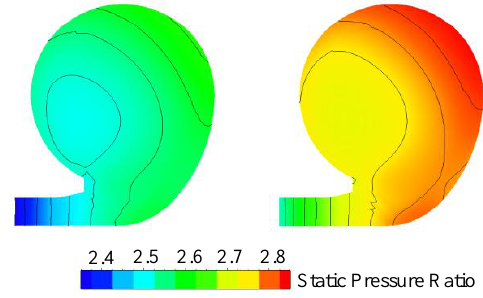
Figure 21. Distribution of static pressure ratio of 0-0 section of the volute ( left : plain, right : plateau).